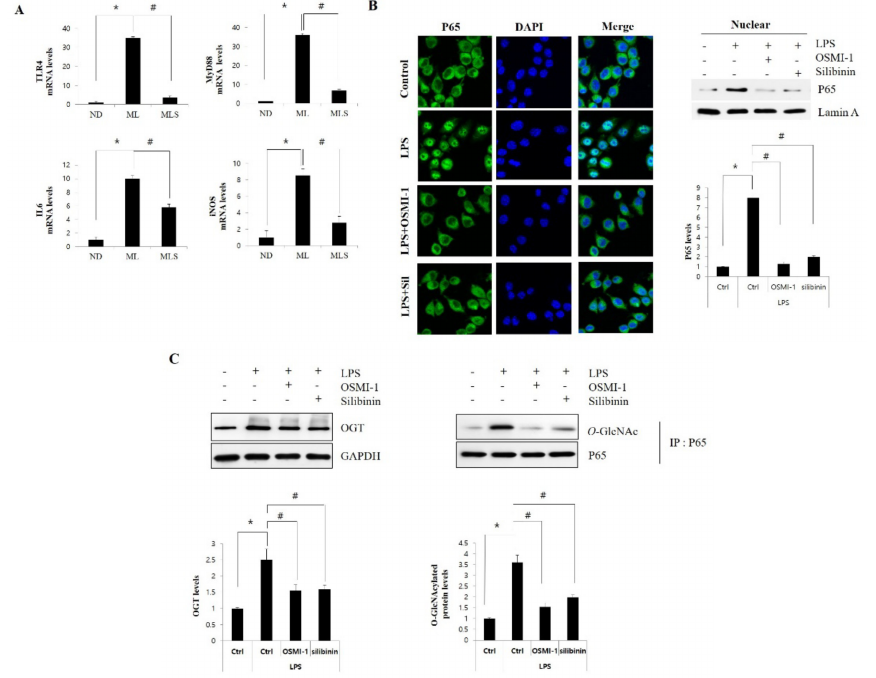
Figure 4. Silibinin inhibits the NF- κ B-signaling pathway of NASH. ( A ) Liver tissue extracts